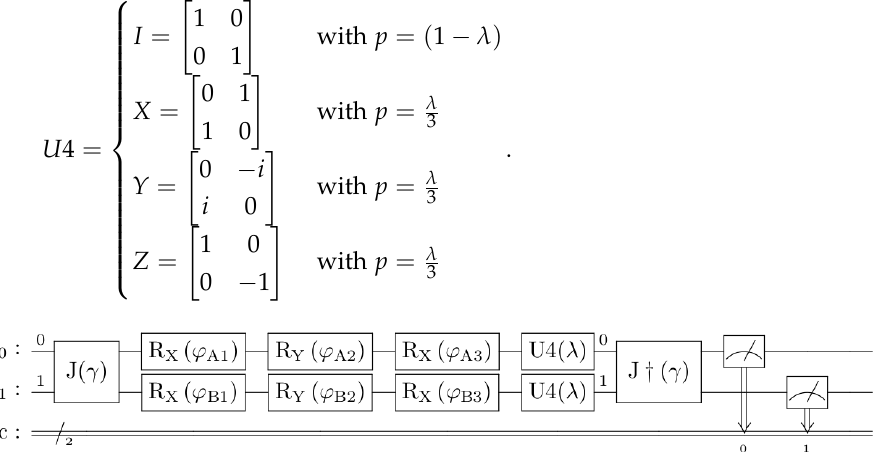
Figure 6. A complete model of the EWL protocol taking into account the entanglement factor and the depolarizing channel noise.